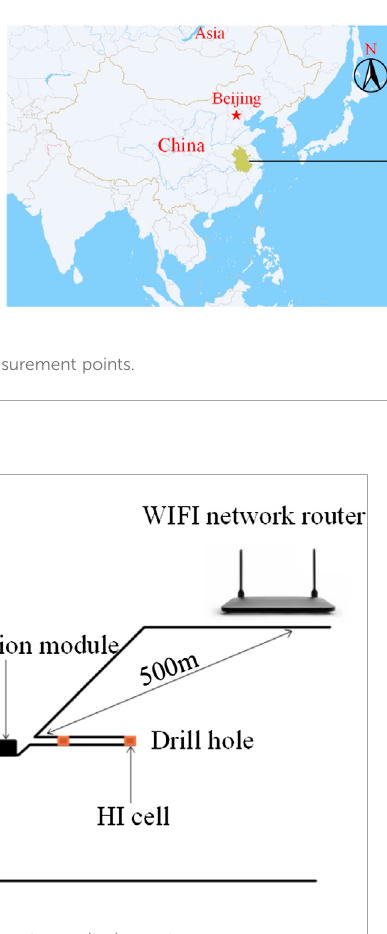
FIGURE 12 Layout scheme of a remote monitoring system.